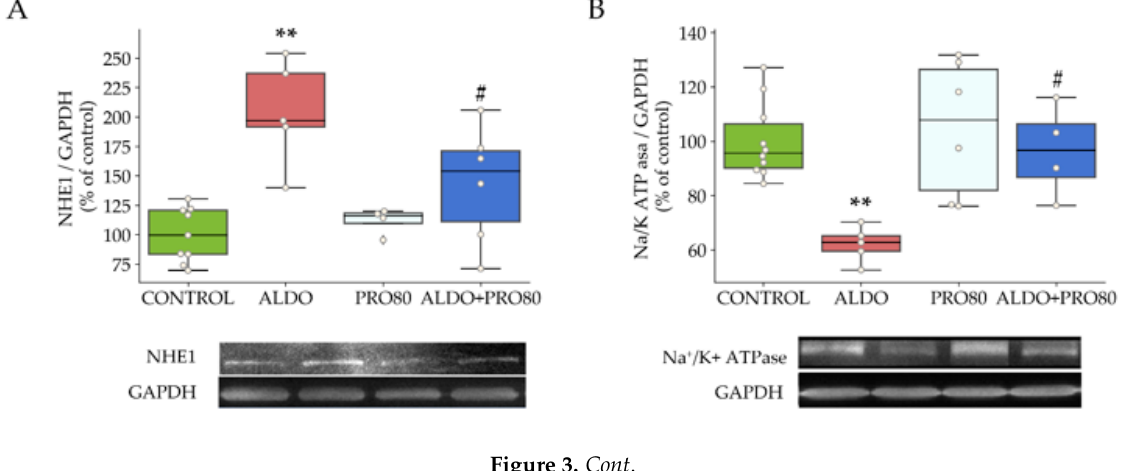
Figure 3. Effect of aldosterone-induced massive entry of sodium; role in NHE1, NKA and NCX1 expression. Relative protein expression levels by western blot of: ( A ): The sodium–hydrogen exchanger type 1 (NHE1), ( B ): The Na+/K+ ATPase pump (NKA) and ( C ): The sodium-calcium exchanger type 1 (NCX1). The boxplots show median, first and third quartile, and minimum and maximum values; the dots show individual values. ** p < 0.01 vs control; # p < 0.05 vs ALDO. CONTROL: Control group; ALDO: Aldosterone-salt group; PRO80: Proanthocyanidins-80% enriched extract group; PRO80+ALDO: Aldosterone plus proanthocyanidins-80% enriched extract group ( n =8).